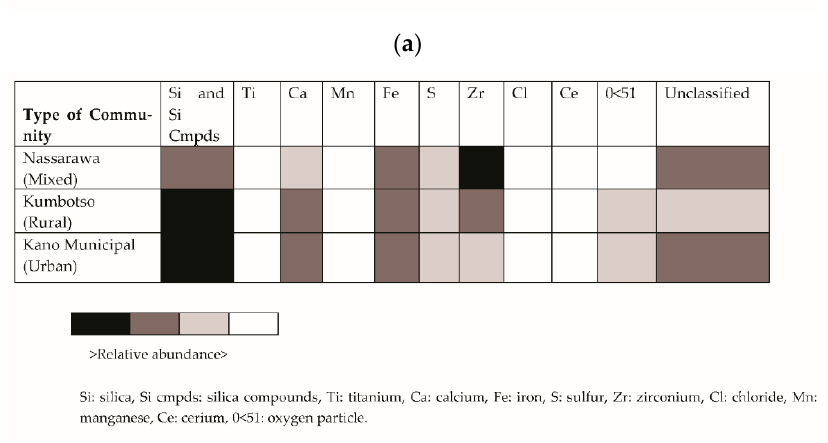
Figure 9. (a) Mineralogy of particles with a size diameter of <2.5 μ m from all collection sites; (b) Figure 8. ( a ) Mineralogy of particles with a size diameter of <2.5 µ m from all collection Mineralogy of particles with a size diameter of 2.5 μ m–<10 μ m from all collection sites.